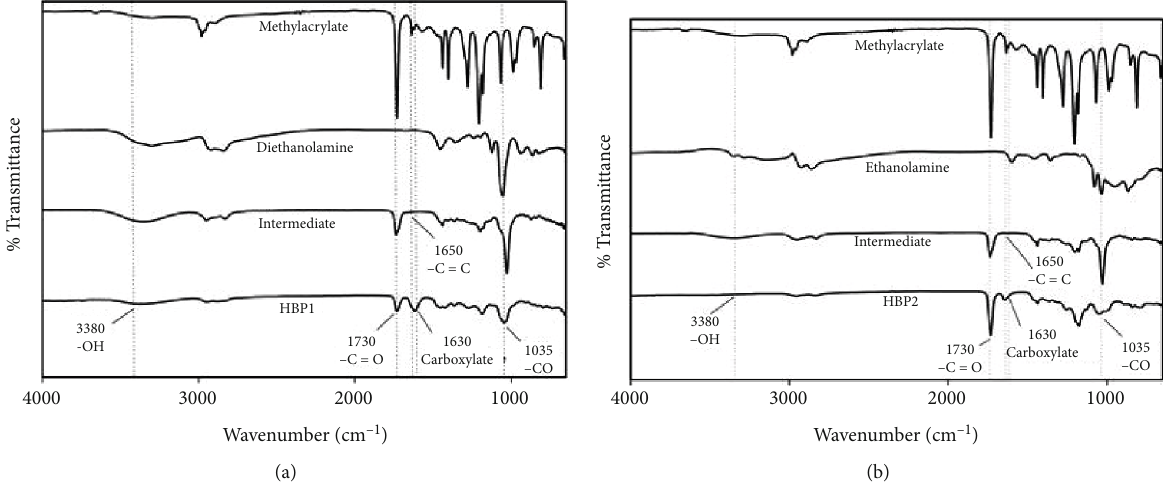
Figure 1: IR spectrum of (a) hyperbranched poly(MA-DEA) (HBP1) and (b) hyperbranched poly(MA-EA) (HBP2).